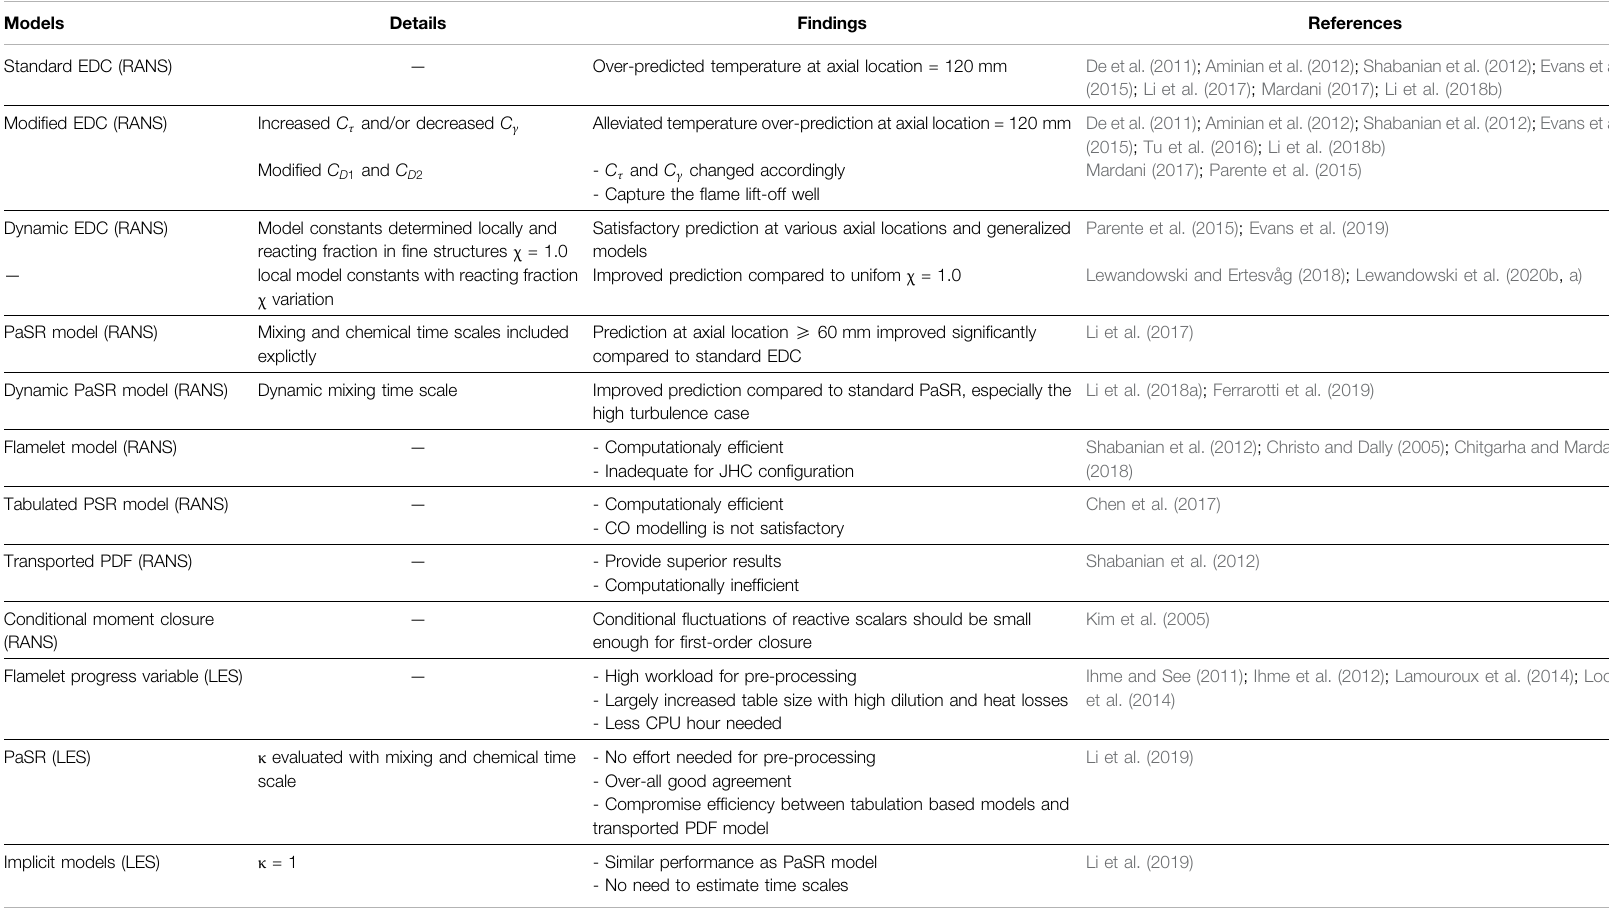
TABLE 1 | Comparison of combustion